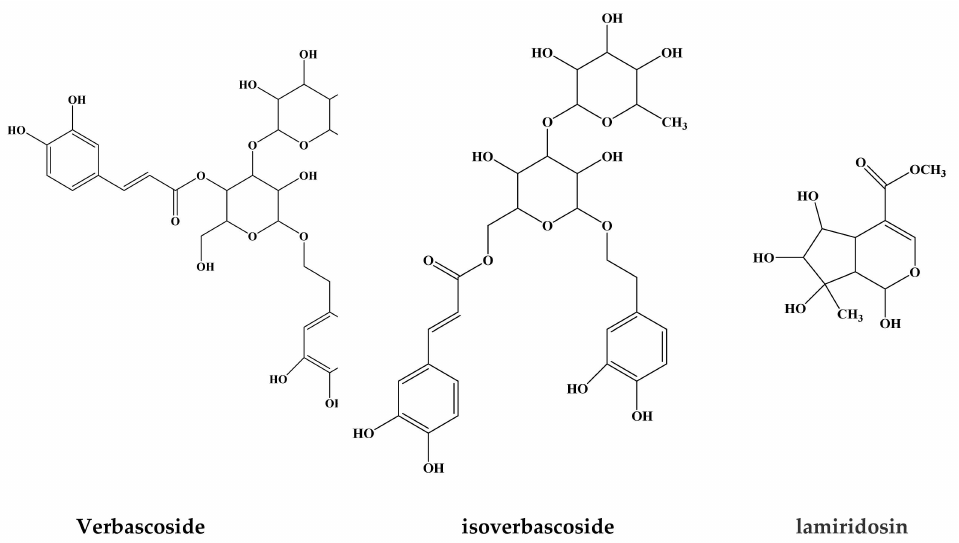
Figure 1. The chemical structure of some biologically active molecules from Lamium